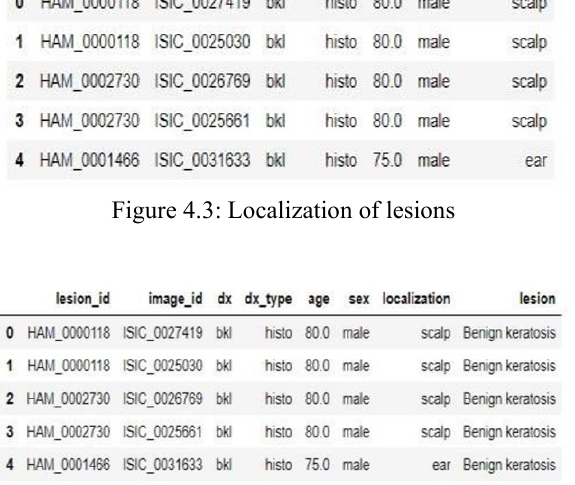
Figure 4.4: Characteristics of lesions Figure 4.5 show the user interface of the system and the predicted output as the type of skin cancer. There is 91.2 accuracy achieved at epoch as 19 for the CNN model.